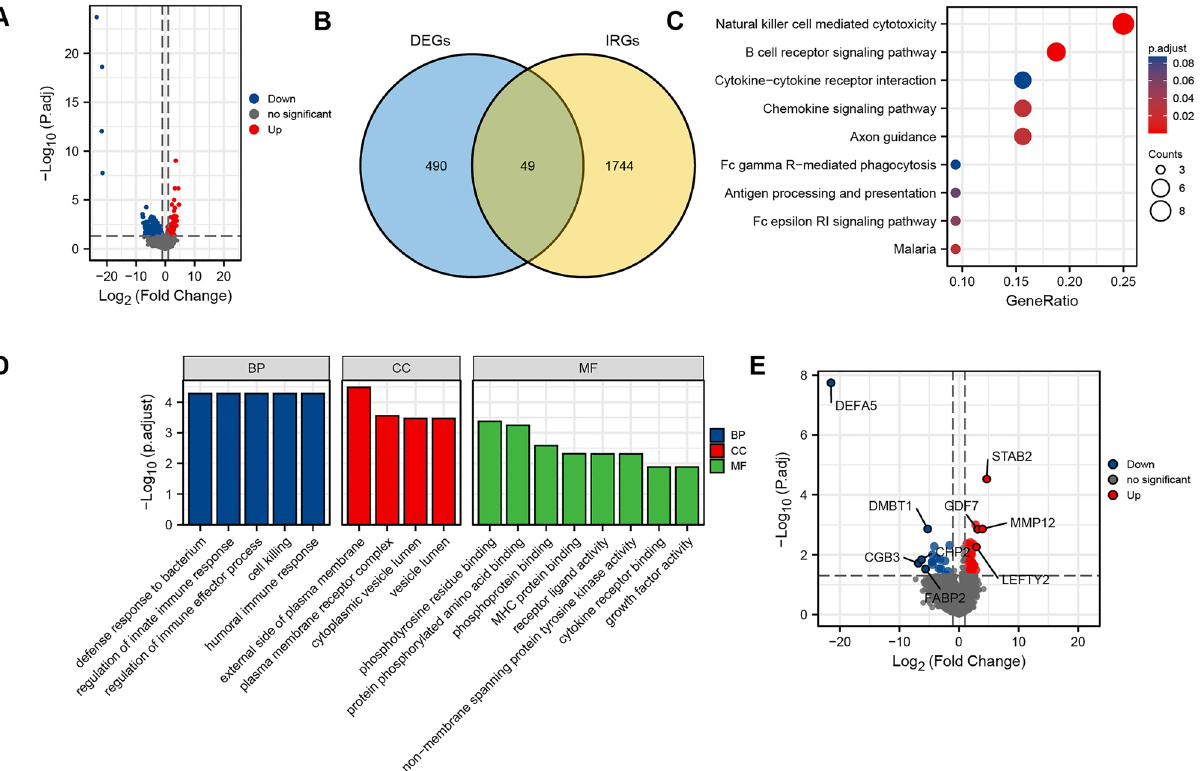
Figure 2. Screening of differentially expressed genes and immune-related genes related to pancreatic adenocarcinoma. ( A ) Volcano plot of 539 DEGs; ( B ) Venn diagram of intersection of DEGs and IRGs. ( C ) KEGG pathways analysis of genes in DEGs & IRGs; ( D ) GO analysis of genes in DEGs & IRGs; ( E ) Volcano plot of 49 genes in DEGs & IRGs. DEGs differentially expressed genes, IRGs immune-related genes, KEGG Kyoto Encyclopedia of Genes and Genomes, GO Gene